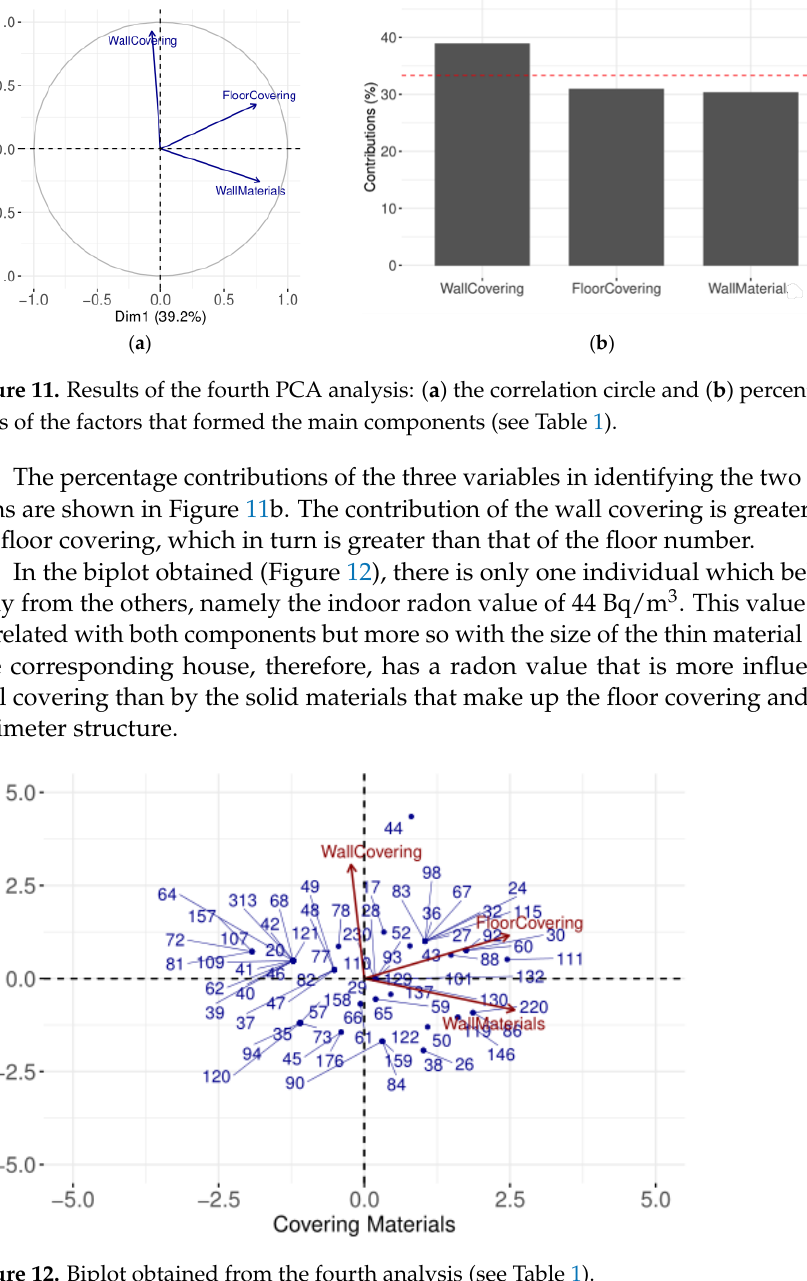
Figure 12. Biplot obtained from the fourth analysis (see Table 1).